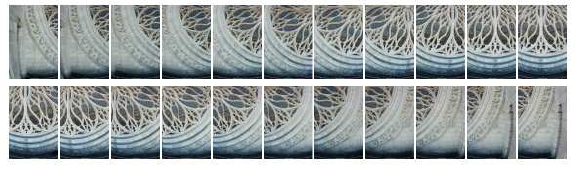
Figure 5: h4 images in the lower level